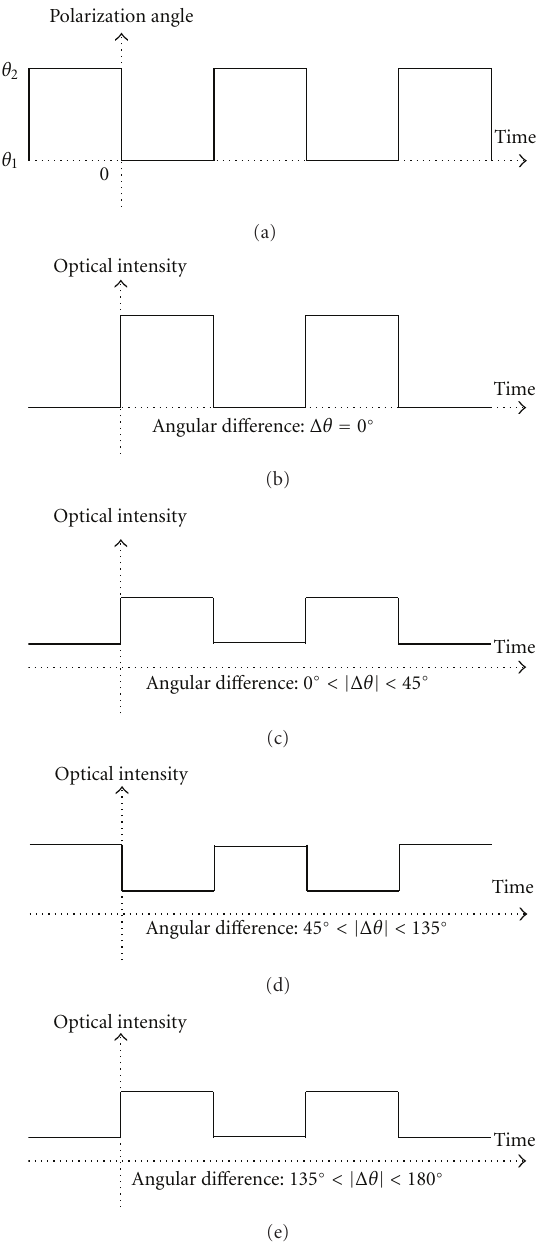
Figure 2: Modulation waveforms for di ff erent polarization bases of the reference beam: (a) polarization modulation, (b)–(e) received signals as a function of the relative angular di ff erence between the transmitter and receiver orientations.